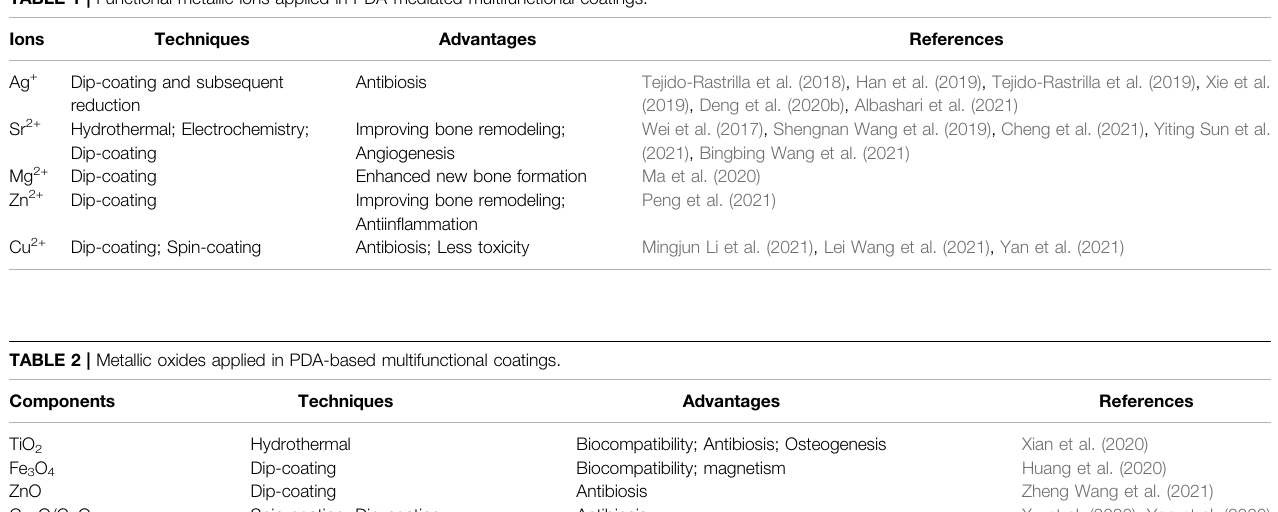
TABLE 1 | Functional metallic ions applied in PDA-mediated multifunctional coatings.